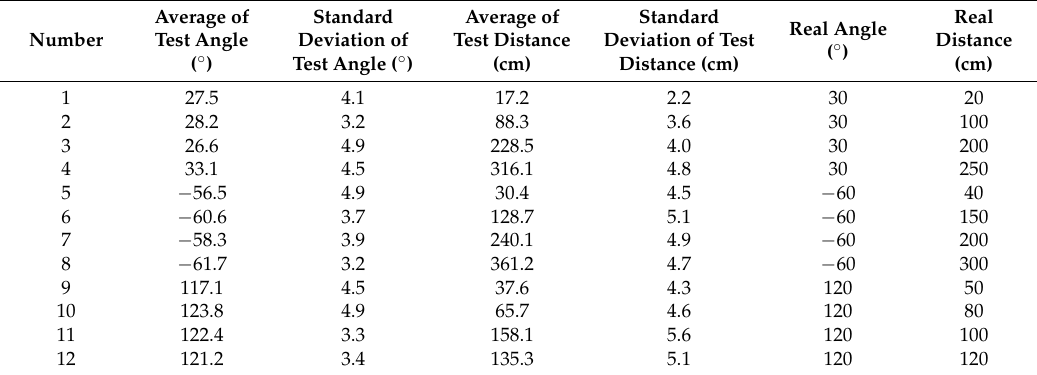
Table 2. Sound localization